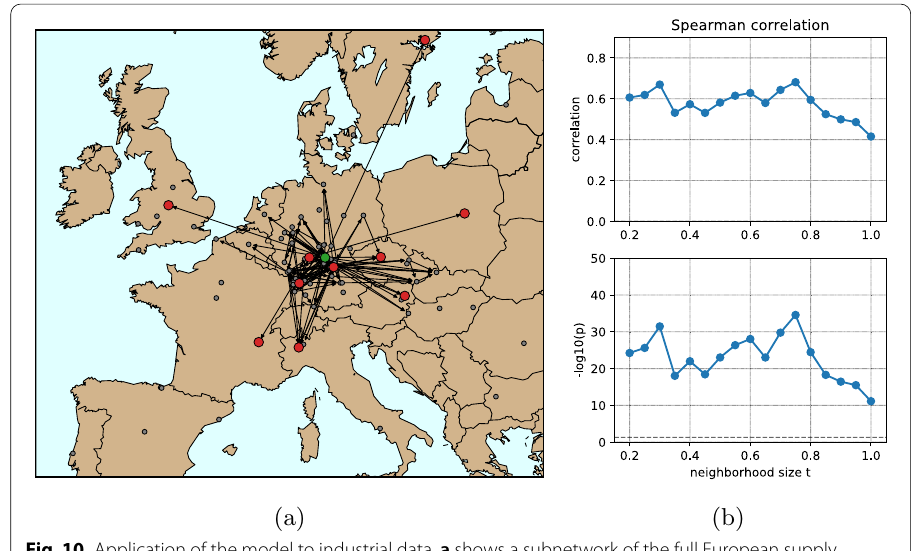
Fig. 10 Application of the model to industrial data. a shows a subnetwork of the full European supply network of an automotive company. The subnetwork is generated by selecting the routes used for transporting one product category and taking a neigborhood of these routes with size parameter t = 0.6 . In b all product subnetworks are analysed together using Spearman correlation (upper panel) and the corresponding p‑value (represented as − log ( p ) ; lower panel) of their r and σ values for different neighborhood sizes t . The dashed lines indicate zero correlation (upper panel) and − log ( 0.05 ) (lower panel),